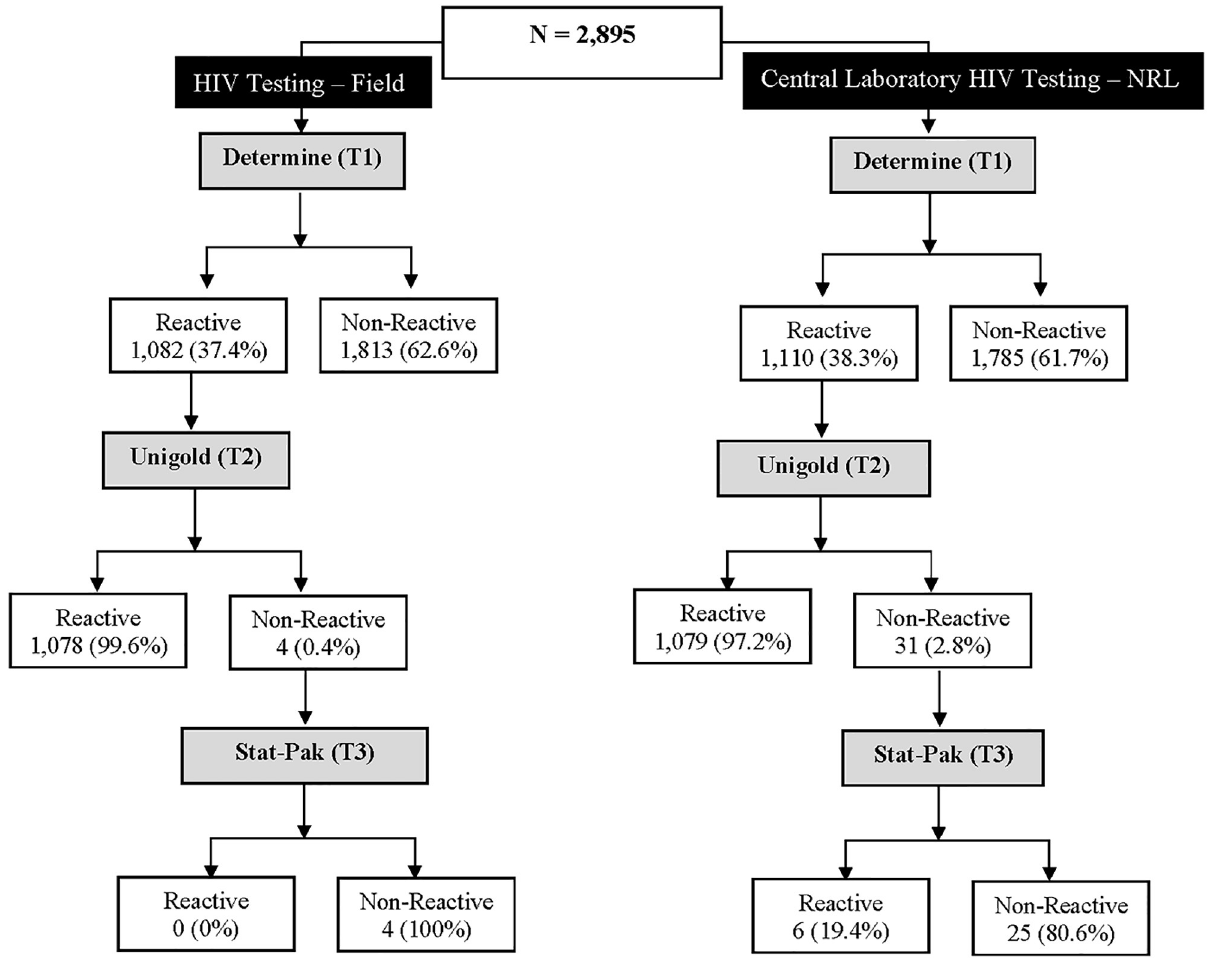
Fig 3. Flowchart of the national serial HIV rapid testing algorithm performed in the field and the NRL for the prospective evaluation.